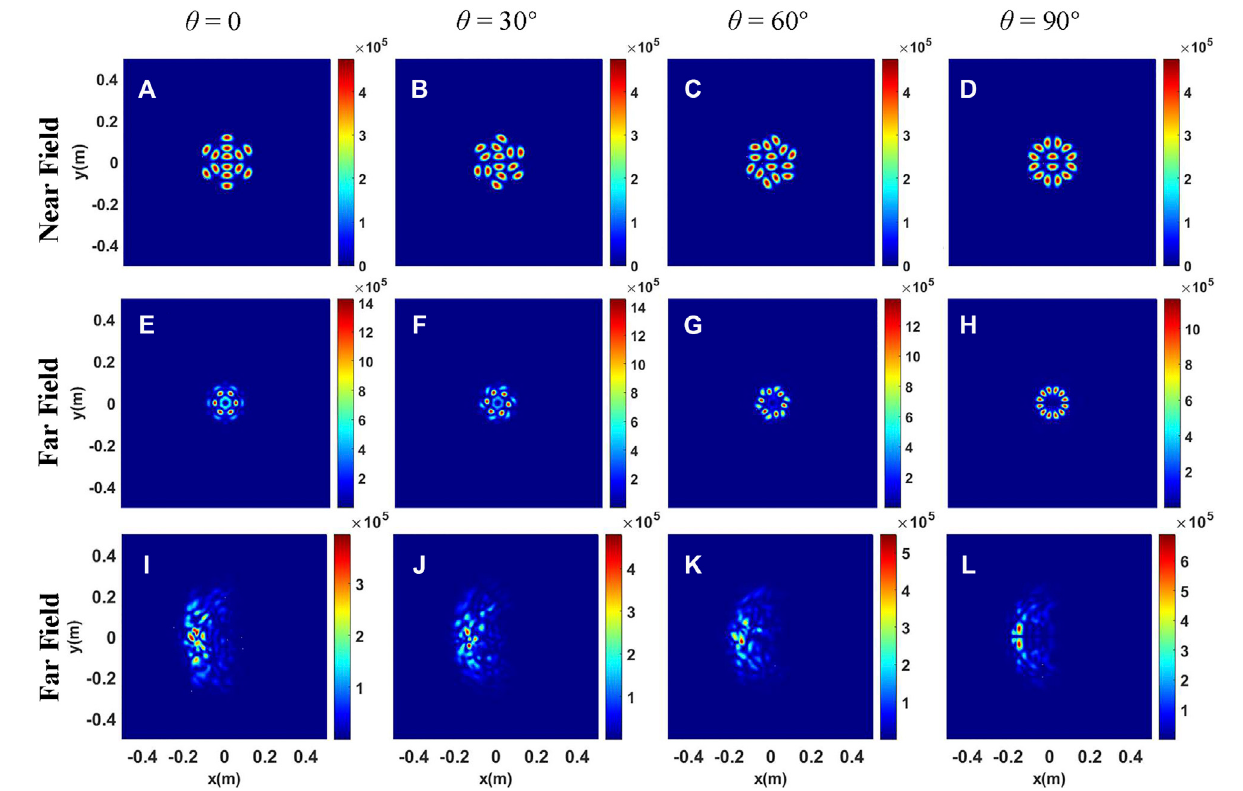
Frontiers in Physics |